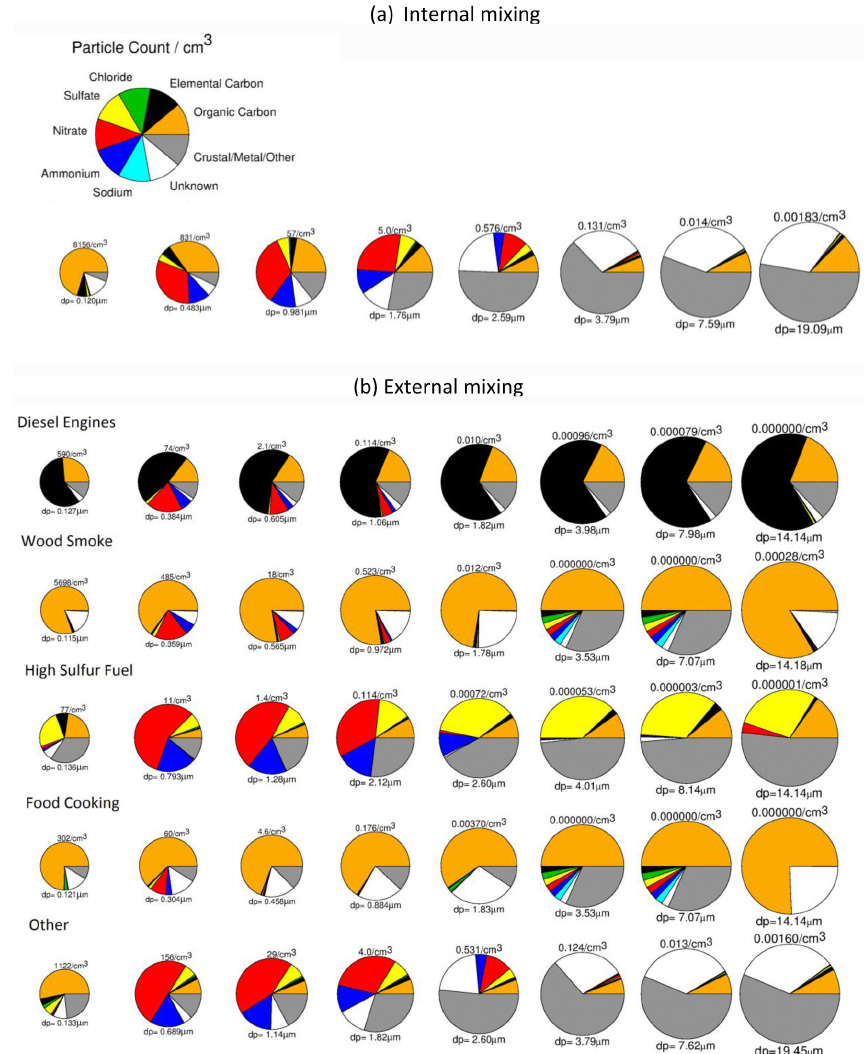
Fig. 2. (a) Internal and (b) external mixing state of the particles averaged from 12:00 to 13:00LT (local time) on 24 December 2000 at surface level in Fresno, CA. Each of the pie charts illustrates the average chemical composition of a particle from a source (row) within a model size bin (column). The size of each pie chart is proportional to the log of the actual particle